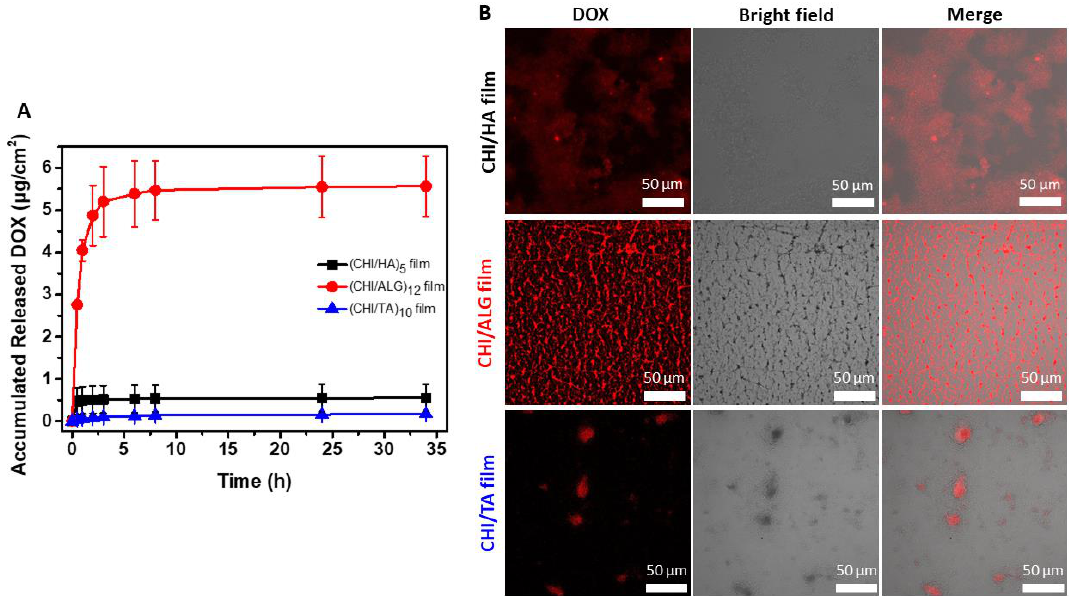
Figure 7. ( A ) Accumulated amount of released DOX from multilayer film under 1× PBS at 37 °C. ( B ) Confocal microscope image of DOX-incorporated multilayer films. Red fluorescence and bright field represent DOX and film structure. To clearly see the DOX fluorescence in the film, we have adjusted the red fluorescence balance. The original images are displayed in Figure S6.